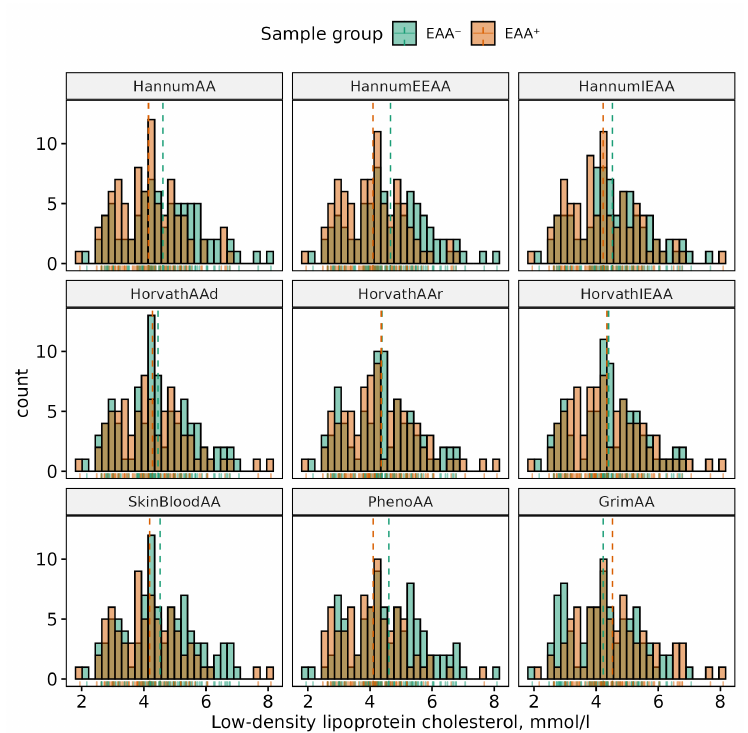
Figure A7. Histograms of distributions of LDL levels in females in EAA + and EAA − groups. Dashed lines correspond to the group means.